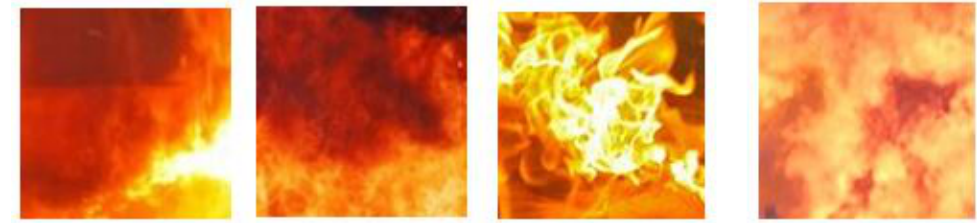
Figure 2. The selected sample of fire images for training data in the segmentation stage.